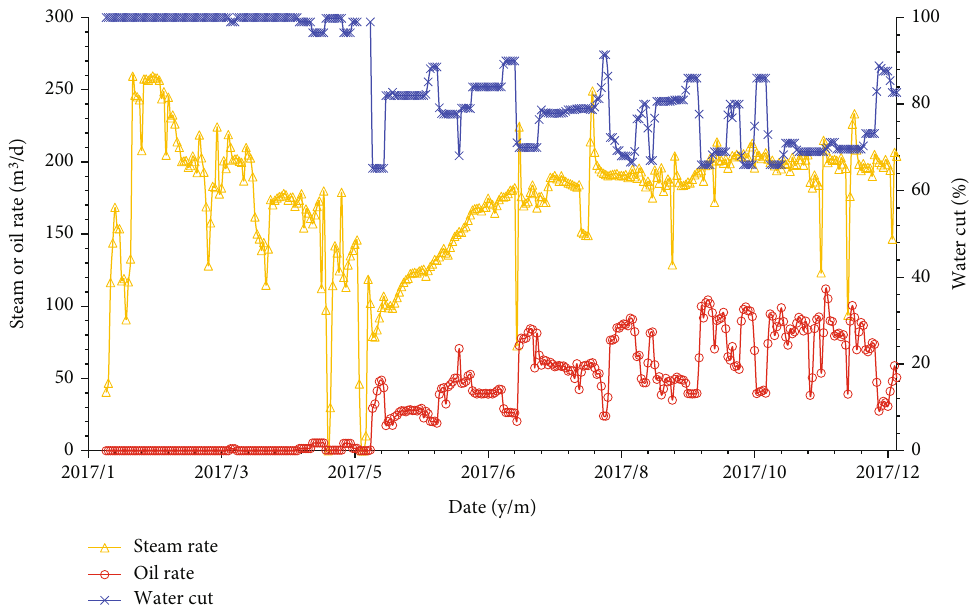
Figure 12: Performance curves at the preheating and subsequent SAGD